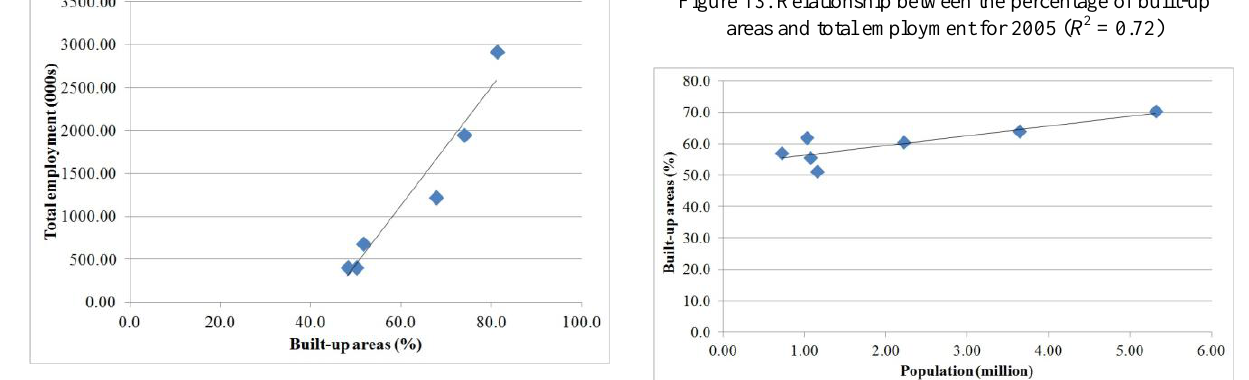
Figure 11. Relationship between the percentage of built-up areas and total employment without Edmonton and Victoria City for 2010 ( R 2 = 0.93)